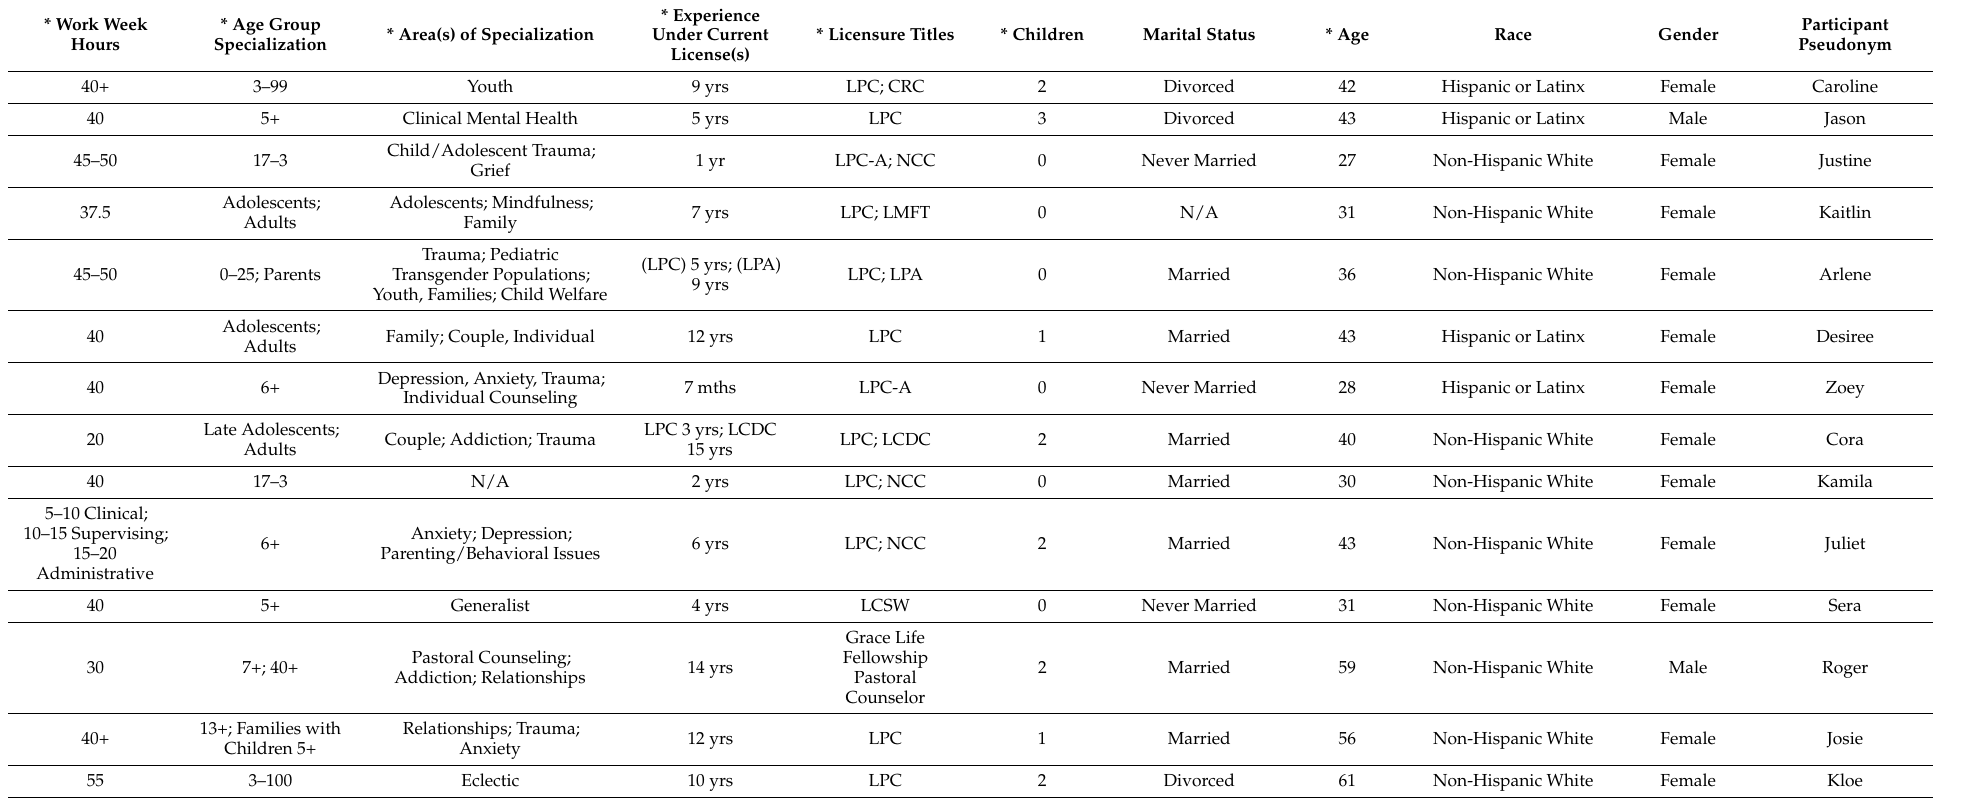
Table 1. Demographics and study qualifications of mental health